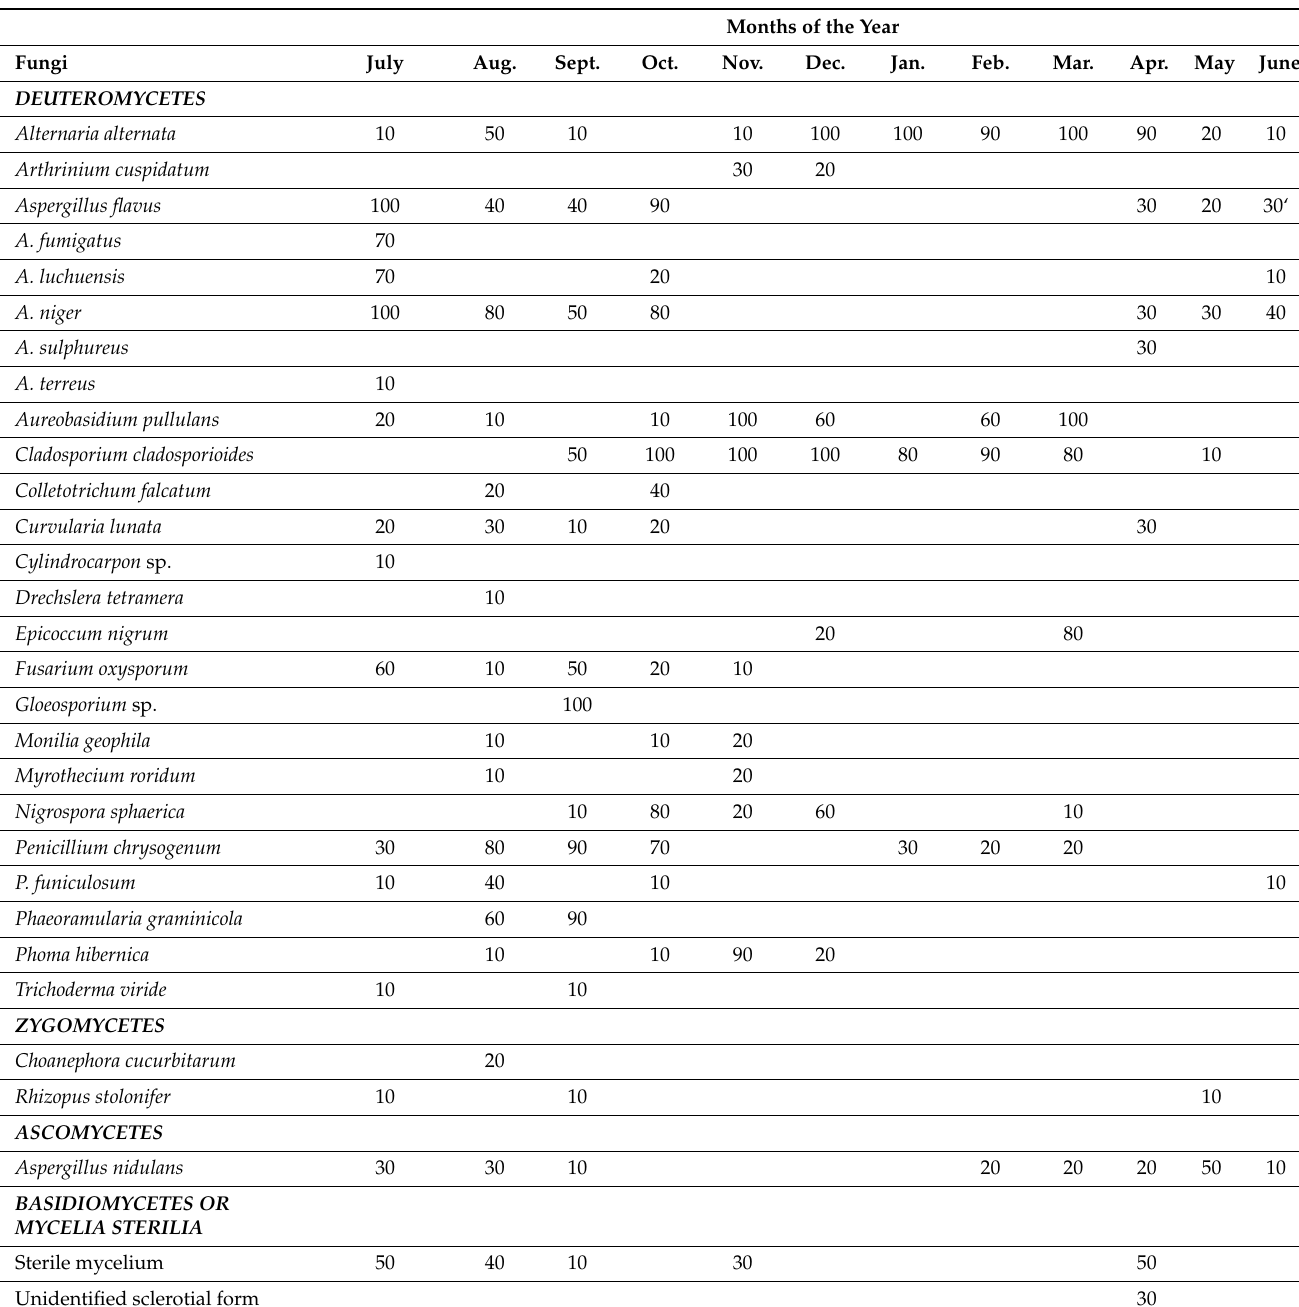
Table 3. Percentage frequency of occurrence of various fungi on leaves before they fall on ground